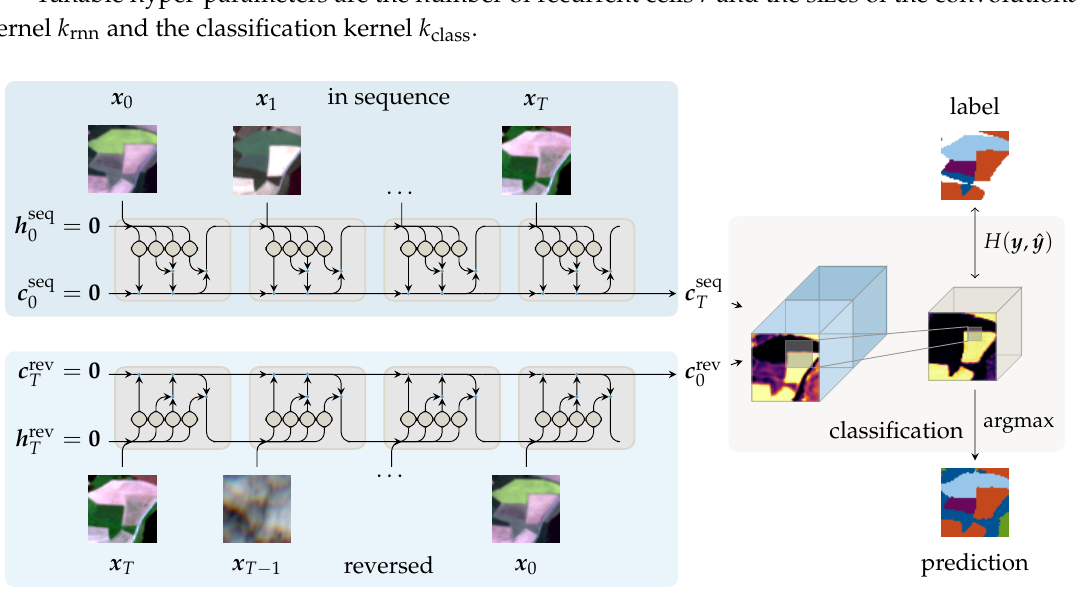
seq ] c inv seq 0 T (cid:107) ] . c inv 0 T k